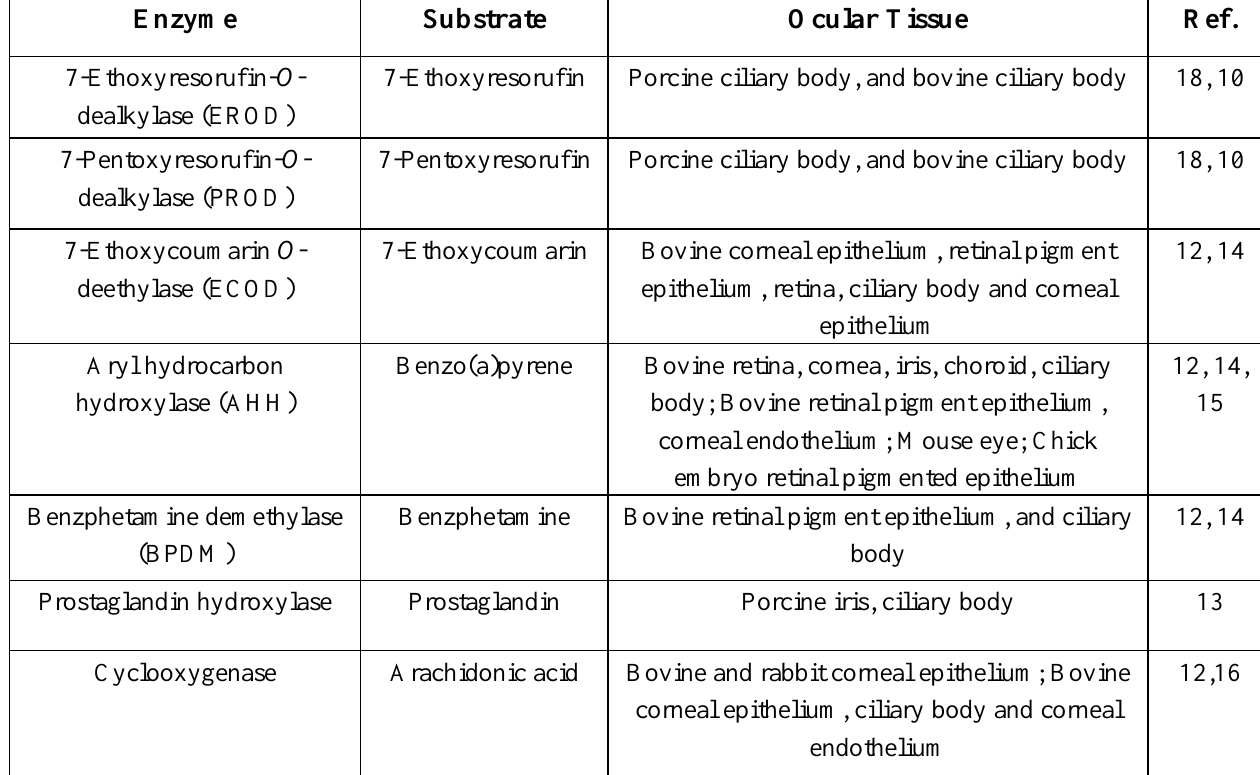
Table 1. Cytochrome P-450-dependent metabolism in ocular